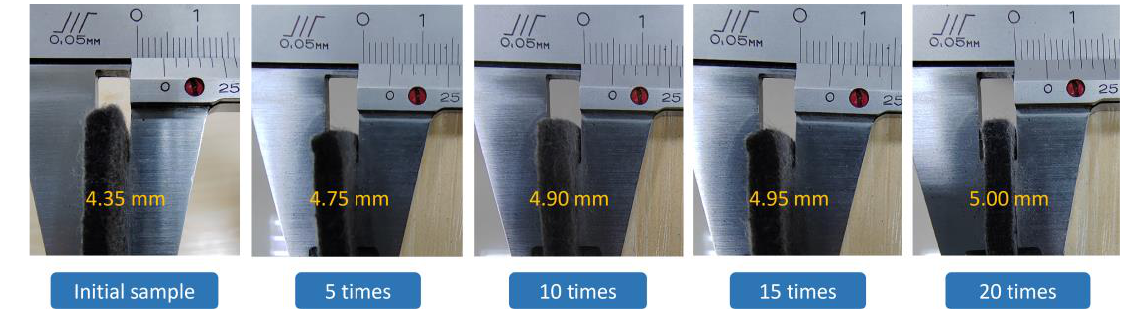
Figure 6. Thickness of samples after different numbers of treatments.